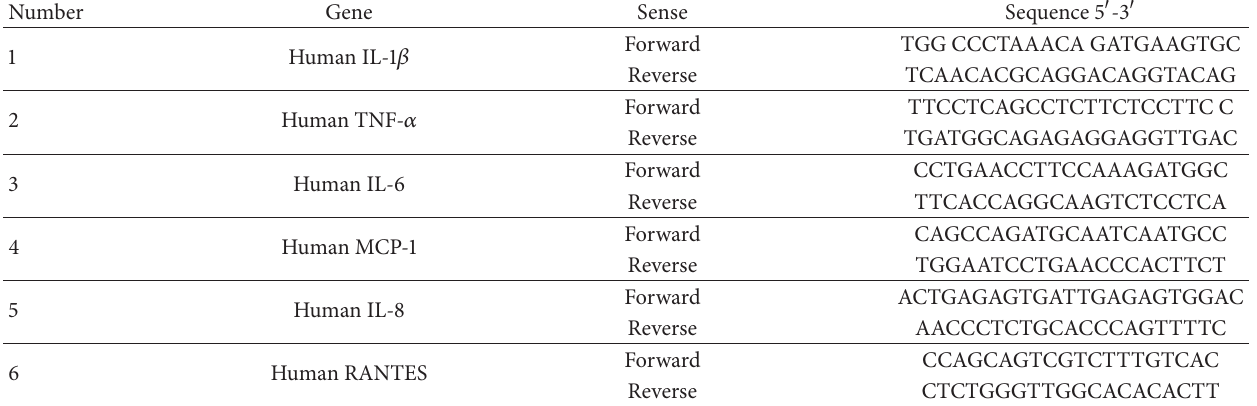
Table 1: The sequence of primers used for real-time PCR experiments to detect the mRNA levels of specified genes in human